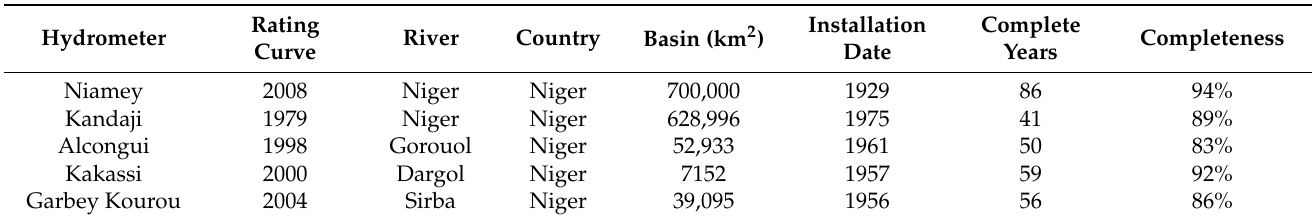
Table 2. The main hydrometers used for flow monitoring on the MNRB. The basin area is computed at the hydrometric gauging